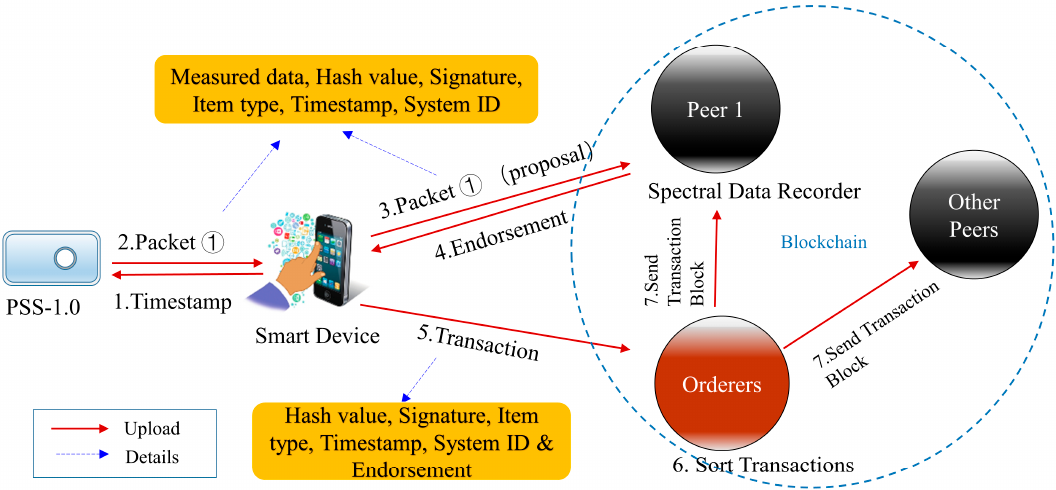
Figure 11. Steps to upload data to and request data from the data recorder in the blockchain system.